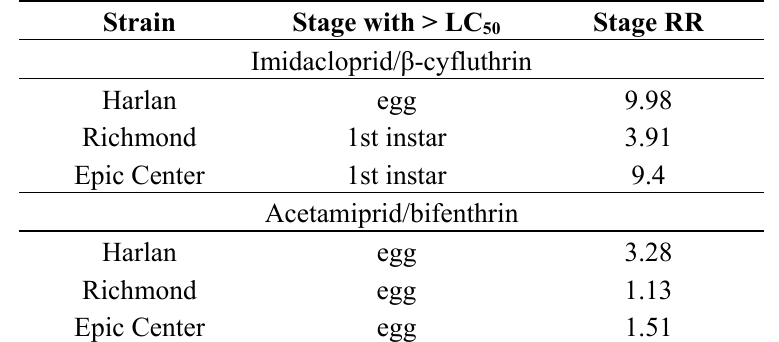
Table 3. Comparison of stage resistance ratios (RR) between eggs and first instars within strain (Harlan pyrethroid susceptible, Richmond pyrethroid resistant and Epic Center pyrethroid resistant). Eggs and first instars were treated with either imidacloprid/ β -cyfluthrin or